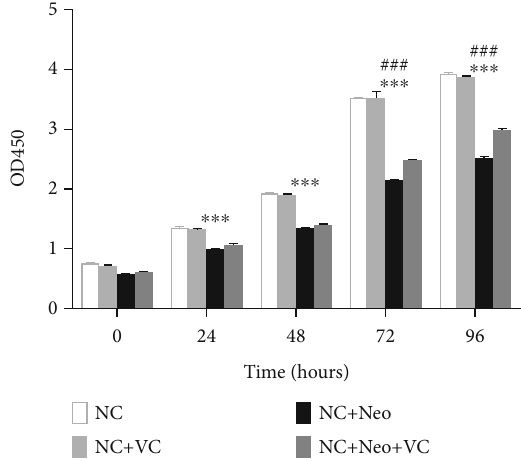
Figure 3: Cell viability treated with neomycin and VC. Cell alive rates were examined using the CCK-8 cell counting kit. Four group cell viabilities were measured at 24, 48, 72, and 96 hours. Detection absorbance at 450nm was determined at the time points. Two-way ANOVA, ∗∗∗ p < 0 : 001 versus NC group and ### p < 0 : 001 versus NC+Neo+VC group. All tests were repeated three times